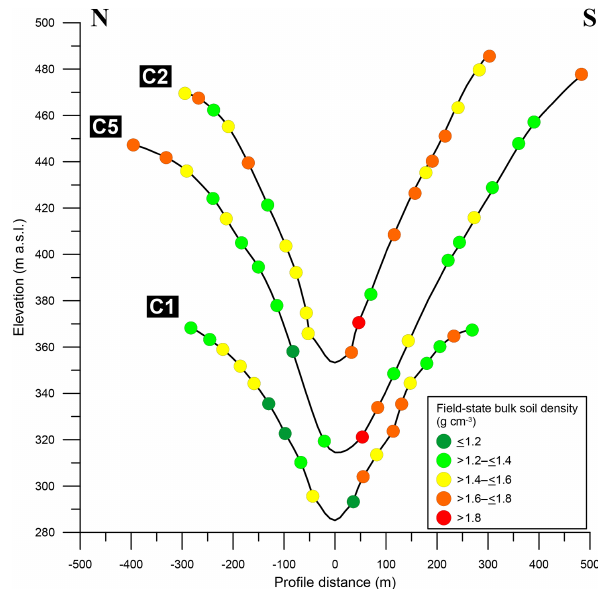
Figure 10. TanDEM-X WorldDEM DTM (digital terrain model)- derived profiles of AT17–18 sampling transects and field-state soil bulk densities calculated from SfM-MVS photogrammetry-based volume derivations and in-field excavation mass weighing. NFSs generally tend to show greater values for ρ B , f than their south- facing counterparts. Contrasts are pronounced in the downslope ar- eas close to the